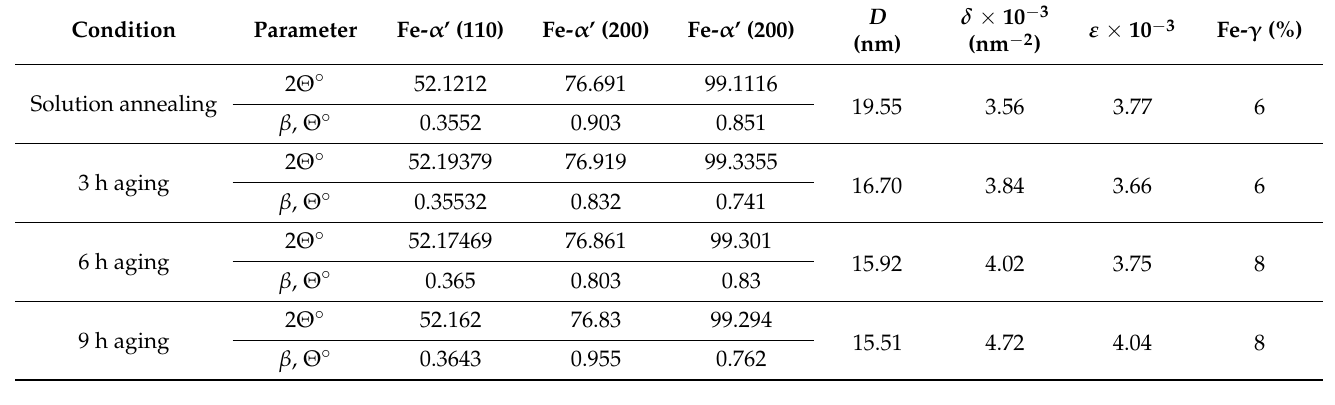
Table 3. XRD diffraction pattern parameters. Figure 6. X-ray diffraction patterns for the solution annealed and aged samples.